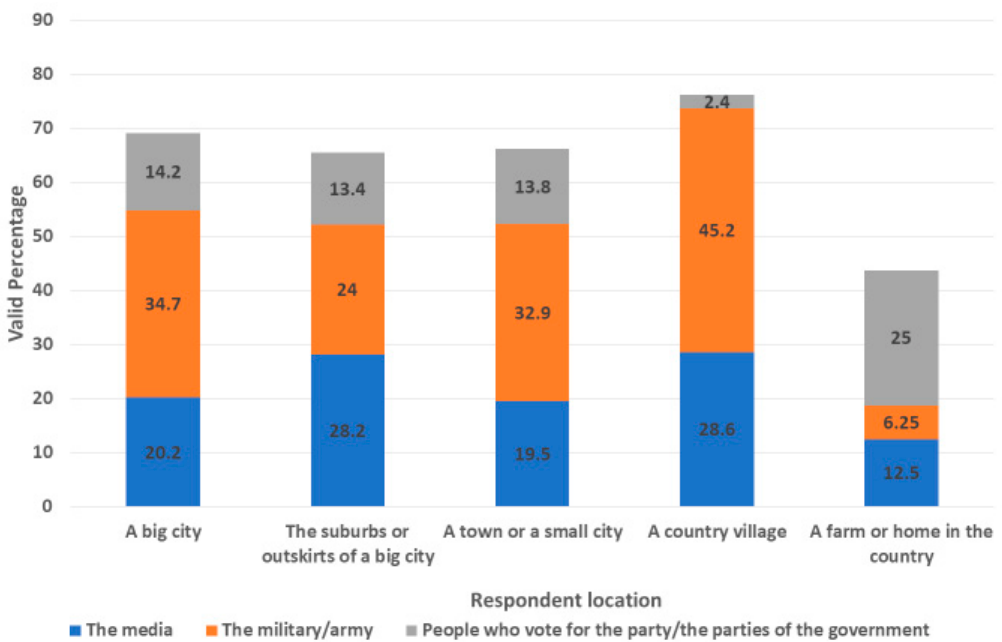
Figure 4. Location of the respondents compared to the percentage of their responses on the most influential groups on government.